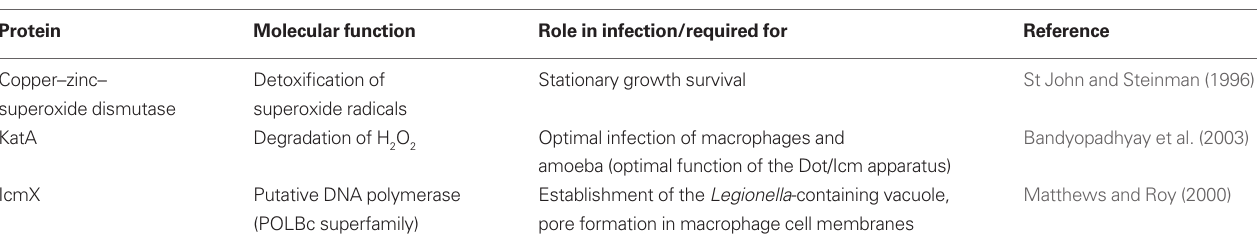
Table 2 | Periplasmic proteins of L. pneumophila associated with virulence and survival . Protein